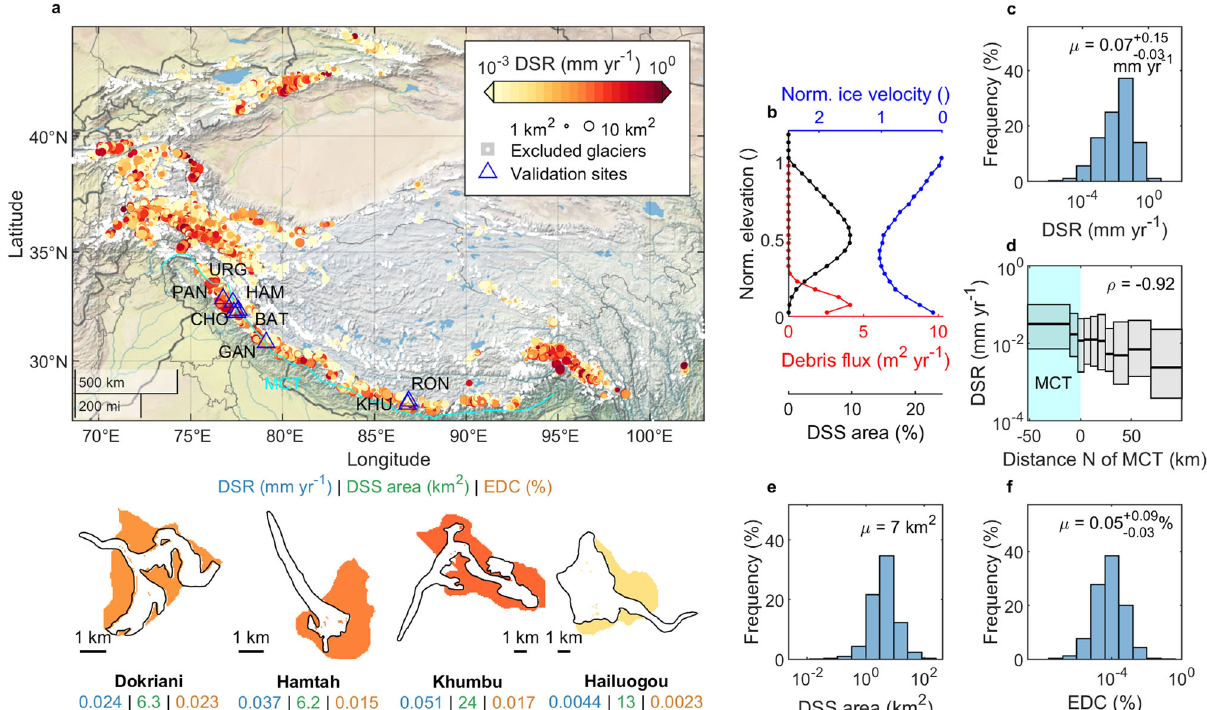
Fig. 2 Debris-supply rate (DSR) and englacial debris content (EDC) in High-Mountain Asia (HMA). a top panel, Debris-supply-slope (DSS) mean debris-supply rate in High-Mountain Asia, with points scaled by debris-supply slope area and base map from Natural Earth, showing the Main Central Thrust (MCT); small panels, debris-supply rate for selected glaciers. b Median supraglacial debris fl ux (red), median glacier – surface velocity (blue) and debris-supply slope area (black) with respect to normalised glacier elevation. c Frequency distribution of debris-supply rate. d Debris-supply slope mean debris-supply rate binned by distance north (N) of the MCT, where Spearman ’ s ρ is calculated for bin centres, where each bin contains one tenth of the data. e Frequency distribution of debris-supply slope area. f Frequency distribution of EDC. μ is mean value. Validation sites are Panchi (PAN), Urgos (URG), Hamtah (HAM), Chhota Shigri (CHO), Batal (BAT), Gangotri (GAN), Khumbu (KHU), Rongbuk (RON).